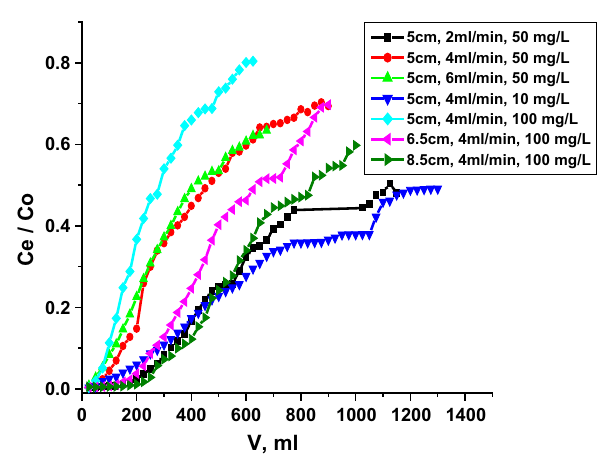
Fig. 12 Effect of various parameters on column studies on biosorp- tion of EB using SB—effect of flow rate—2, 4 and 6 ml/min, dye concentration 50 mg/L, BH 5 cm; effect of dye concentration10, 50 and 100 mg/L, BH 5 cm, flow rate 4 ml/min; effect of bed height 5, 6.5 and 8.5 cm, dye concentration 100 mg/L, flow rate 4 ml/min)